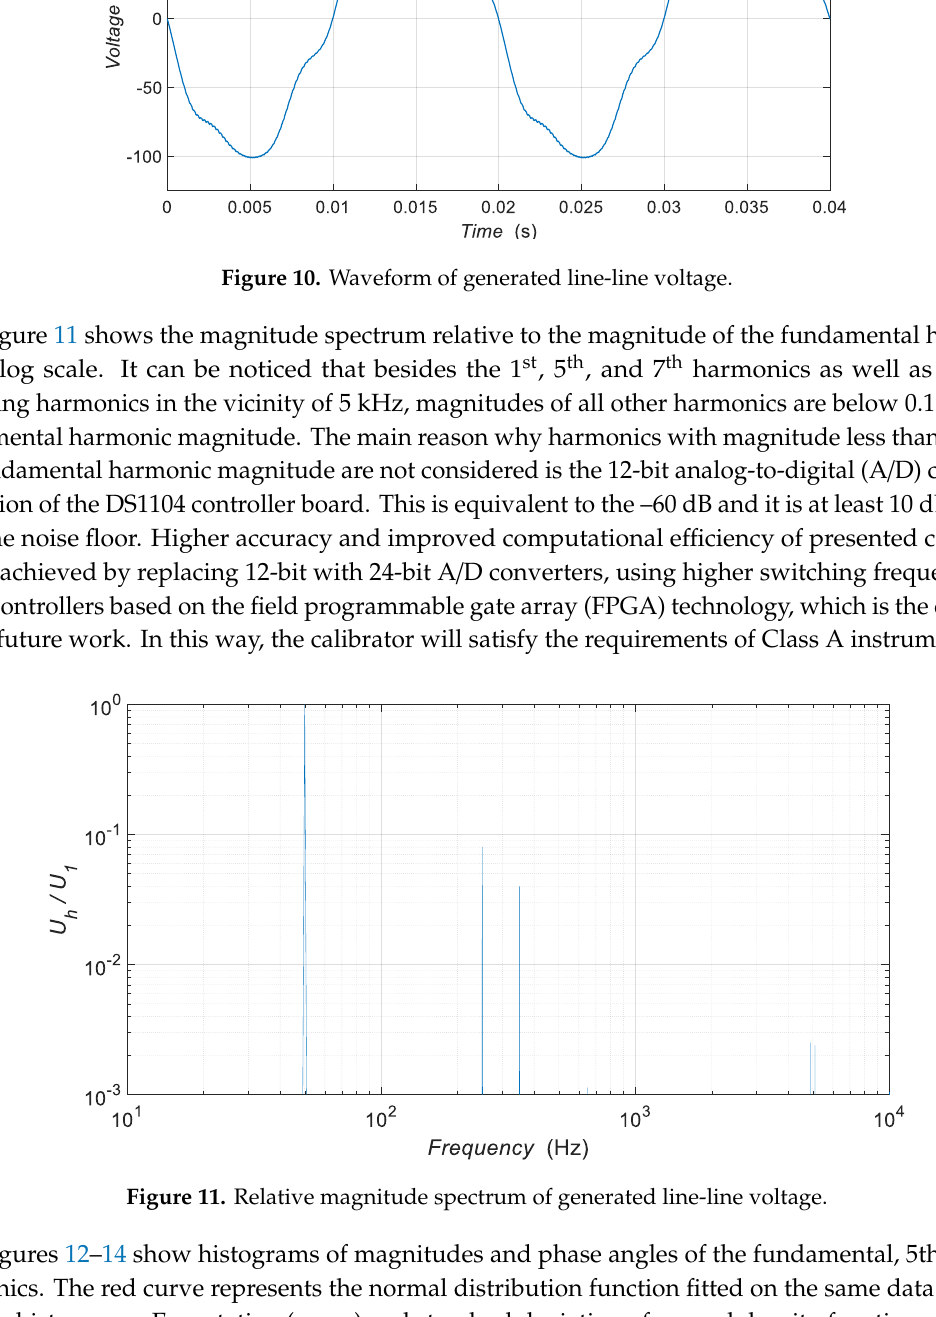
Figure 12. Histogram of fundamental harmonic magnitude and phase angle.